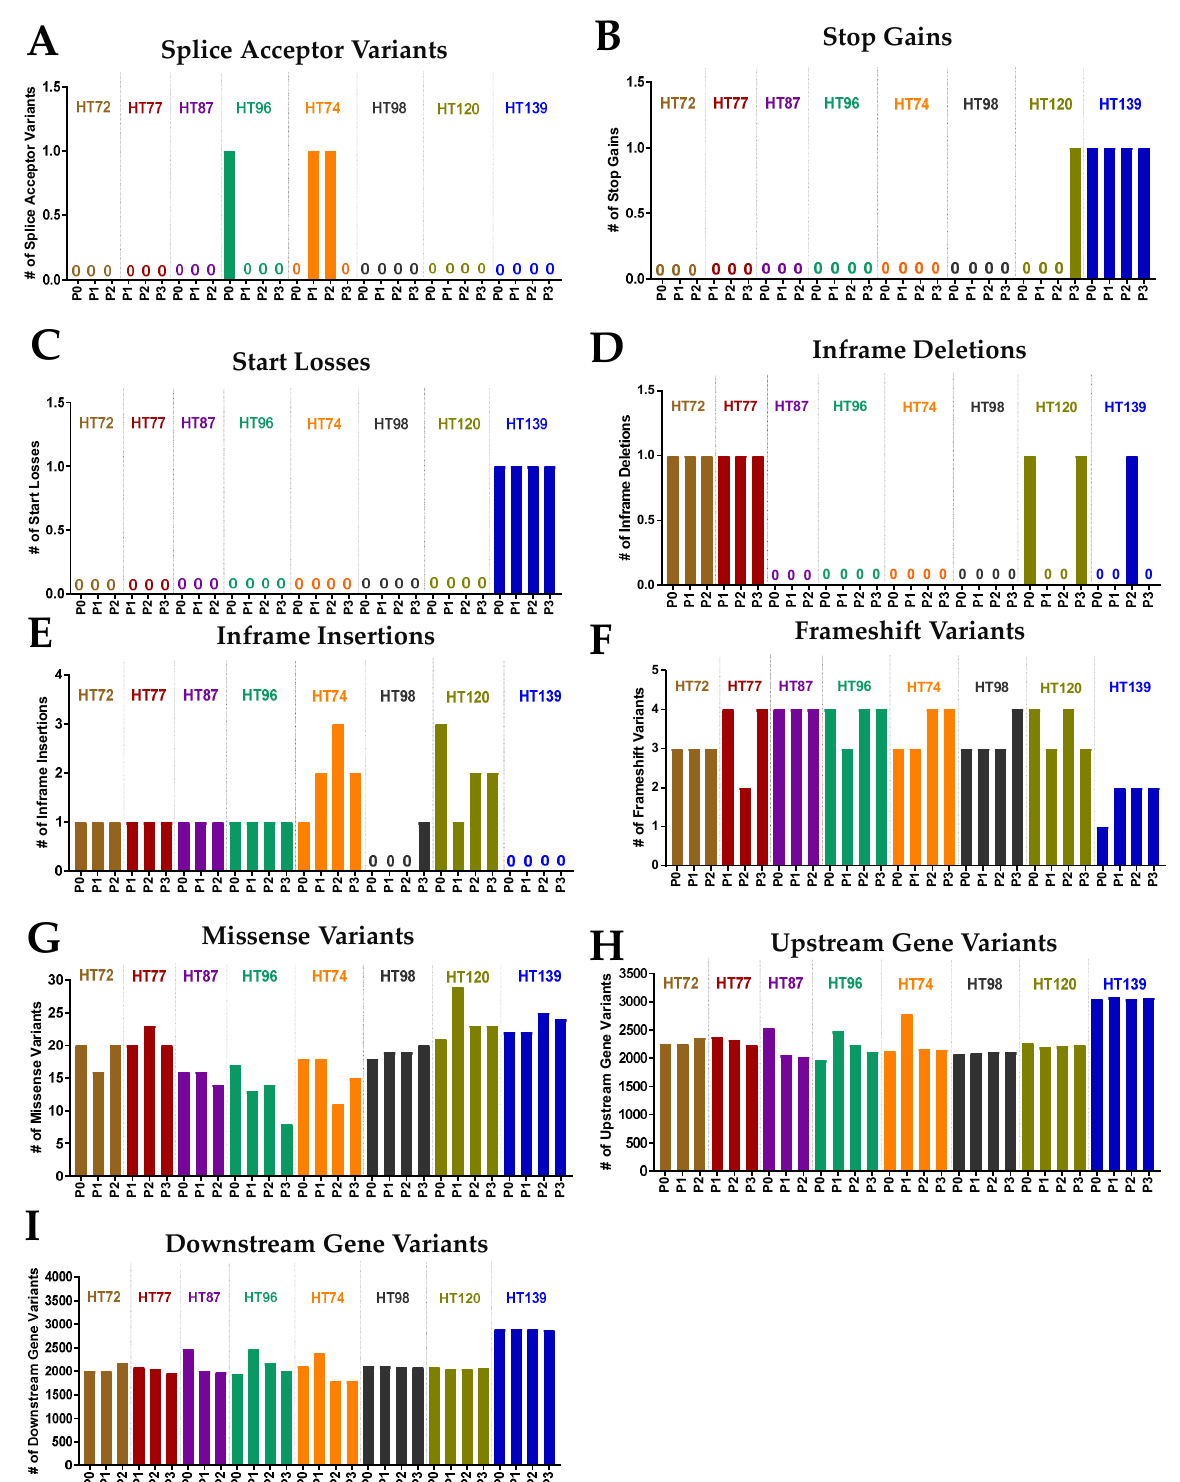
Figure 9. Number of variant consequences in COSMIC genes of P0 and their corresponding PDXs. ( A ) Splice acceptor variants, ( B ) stop gains, ( C ) start losses, ( D ) in-frame deletions, ( E ) in-frame insertions, ( F ) frameshift variants, ( G ) missense variants, ( H ) upstream gene variants, ( I ) downstream gene variants. The data were normalized against sequencing depth.